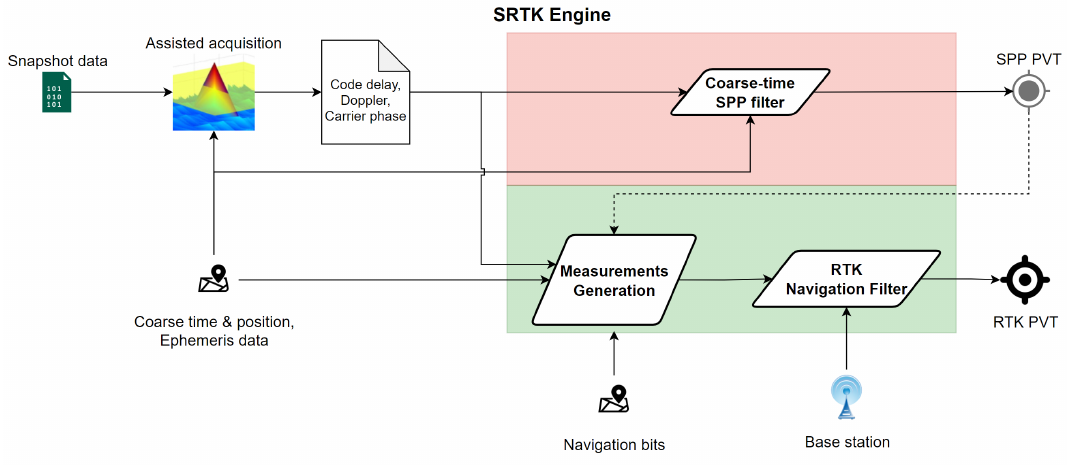
Figure 2. SRTK data processing